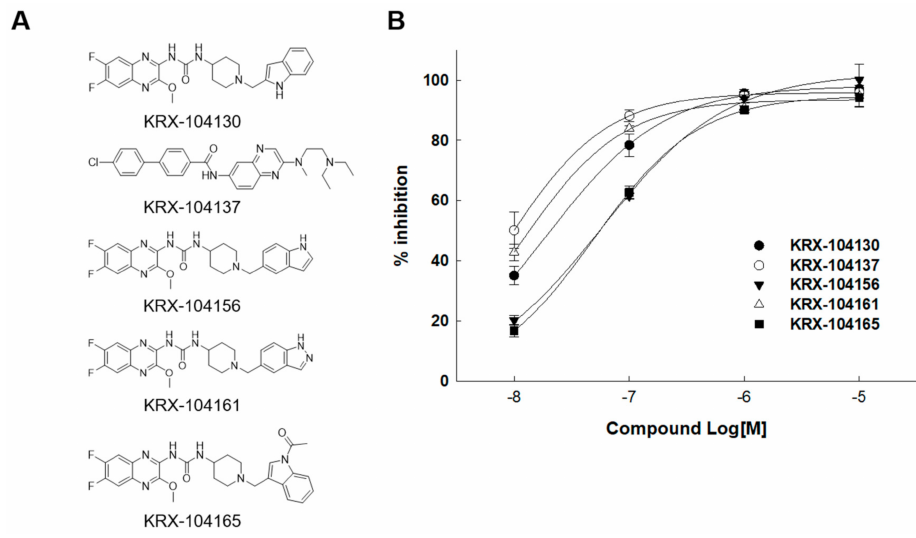
Figure 2. Results of MCH activity of compounds. ( A ) Structures of five compounds with MCH activity and ( B ) their inhibition rate.